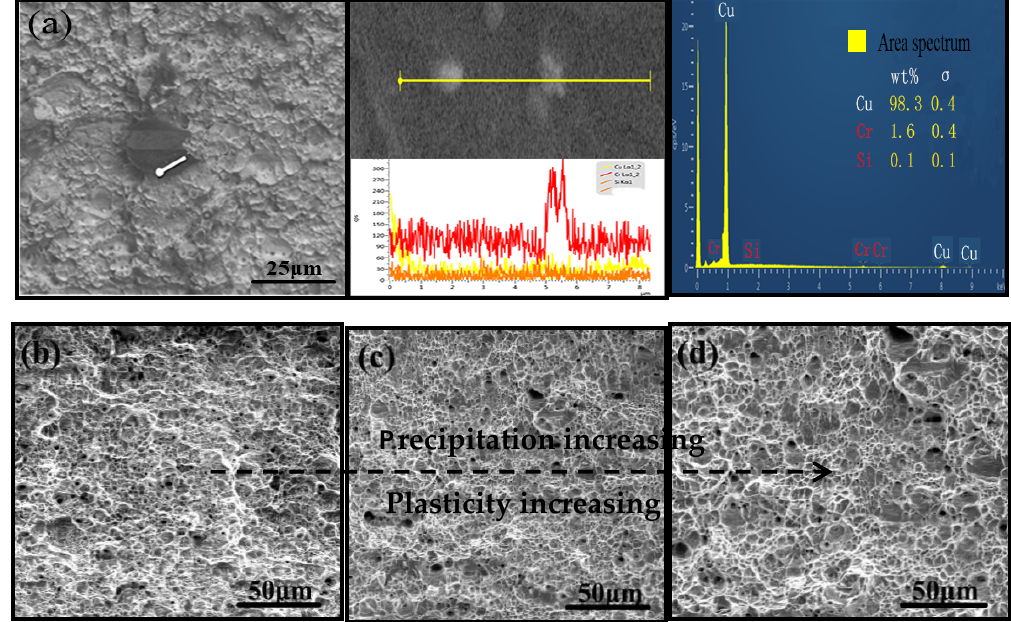
Figure 6. Fracture characteristics of Cu1.5Cr0.1Si alloy after five passes of ECAP deformation and aging at 350 °C; ( a ) Energy spectrum ( b ) 1 pass ( c ) 4 passes ( d ) 8 passes.